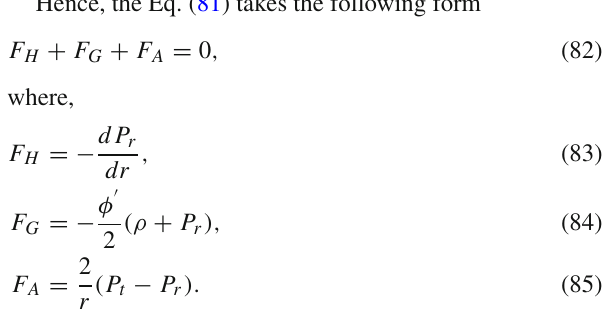
with another force called anisotropic ( F A ) force (because of anisotropic